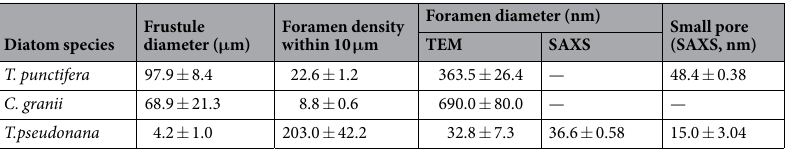
Table 1. Frustule morphology (frustule diameter, foramen density and foramen diameter) of three diatom species based on TEM and the SAXS modeling Eq.